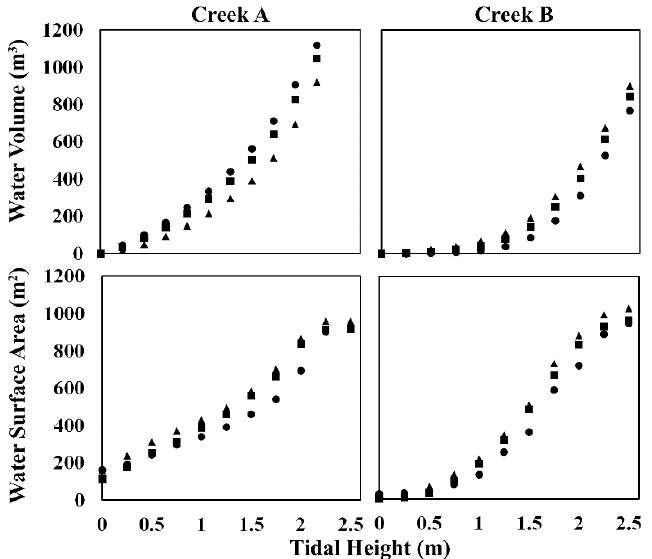
Figure 15. Estimates of water volume (top row) and surface area (bottom row) for two sections of creek within the study area, derived from tidal modelling based on 0.25 m resolution (circles), 0.5 m resolution (squares), and 1 m resolution (triangles) representations of geomorphology with terrestrial lidar (Figure 7).